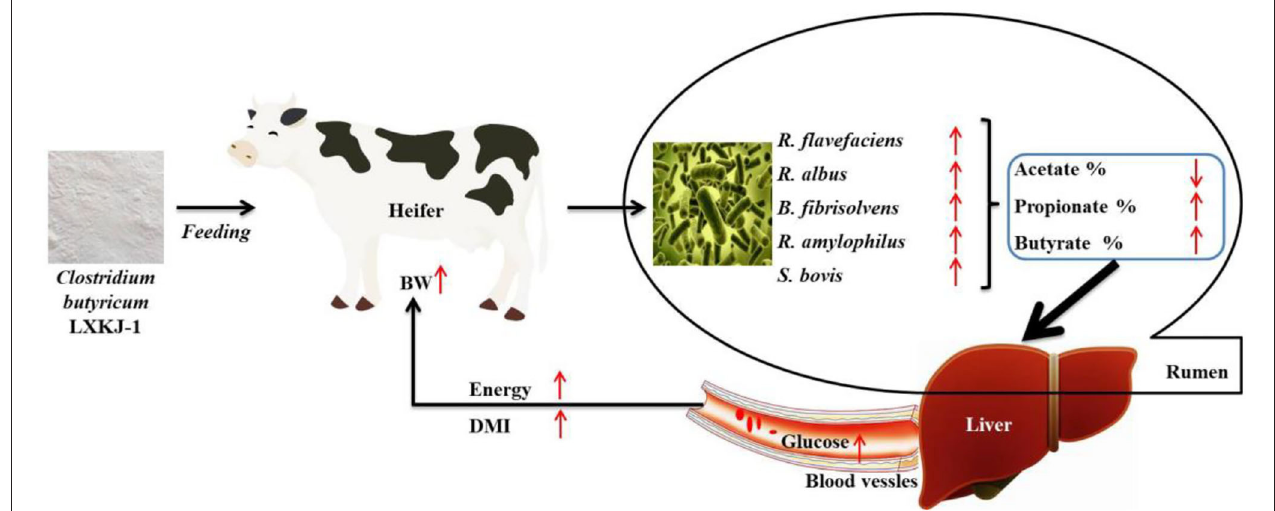
FIGURE 1 | Pathway of Clostridium butyricum regulation of rumen fermentation to improve the growth performance of heifer.